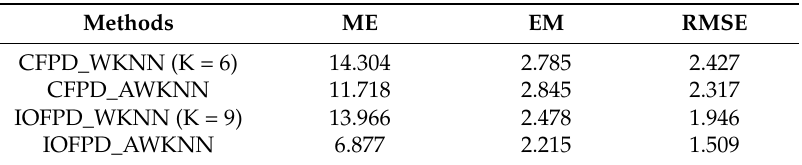
Table 2. The positioning error statistics of the CFPD_WKNN method, CFPD_AWKNN method,